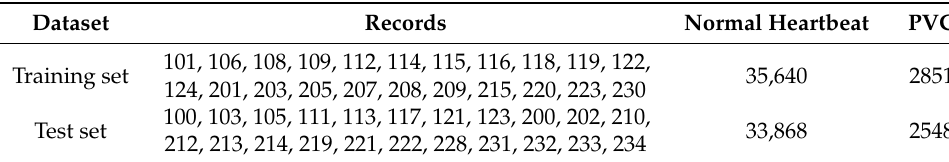
Table 5. Dividing ECG into a training set and test set.